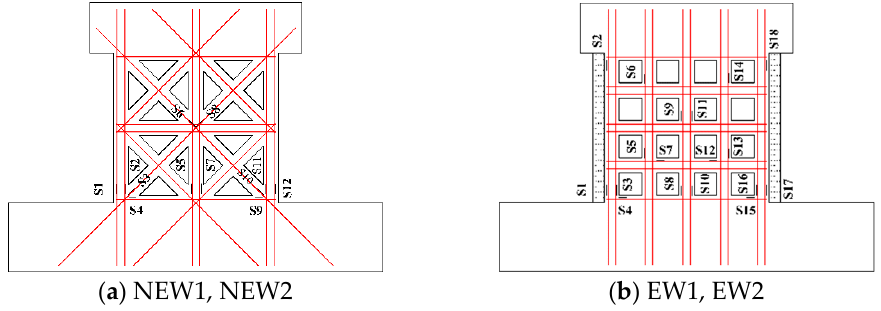
Figure 6. Arrangement of strain gauges of specimens.